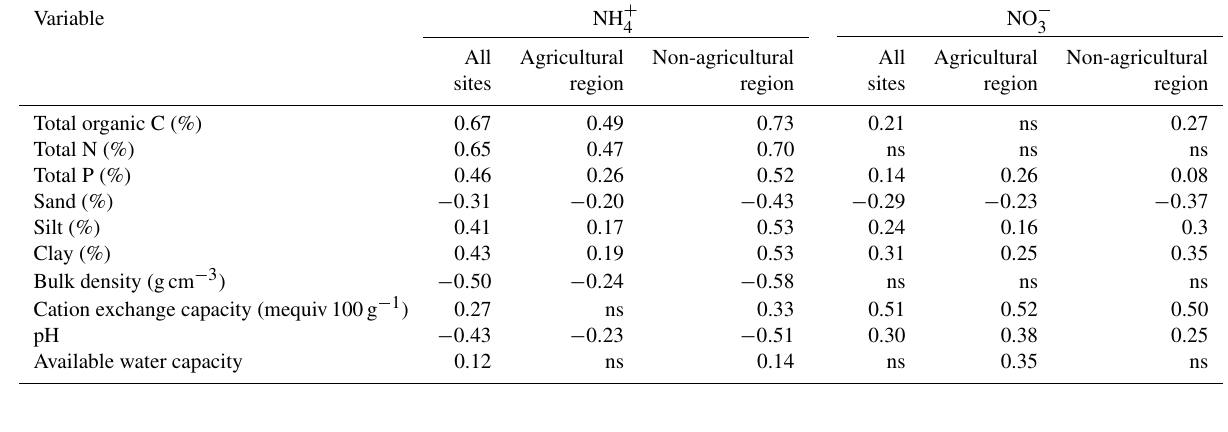
+ or NO − (mgNkg − 1 ) and selected soil variables at p -value < 0 . 05 4 3